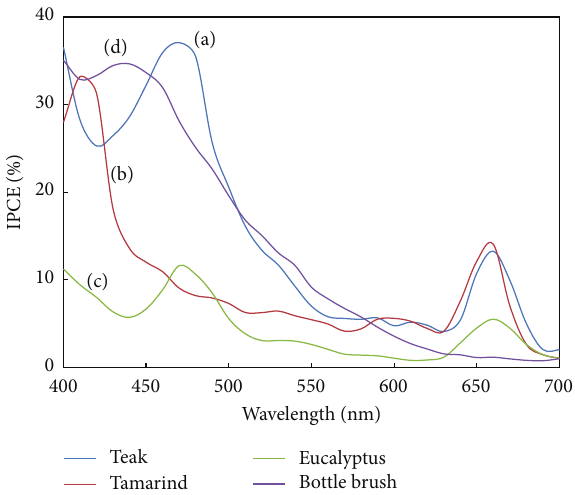
Figure 8: Action spectra of solar cell sensitized by the extracts (a) teak, (b) tamarind, (c) eucalyptus, and (d) bottle brush.